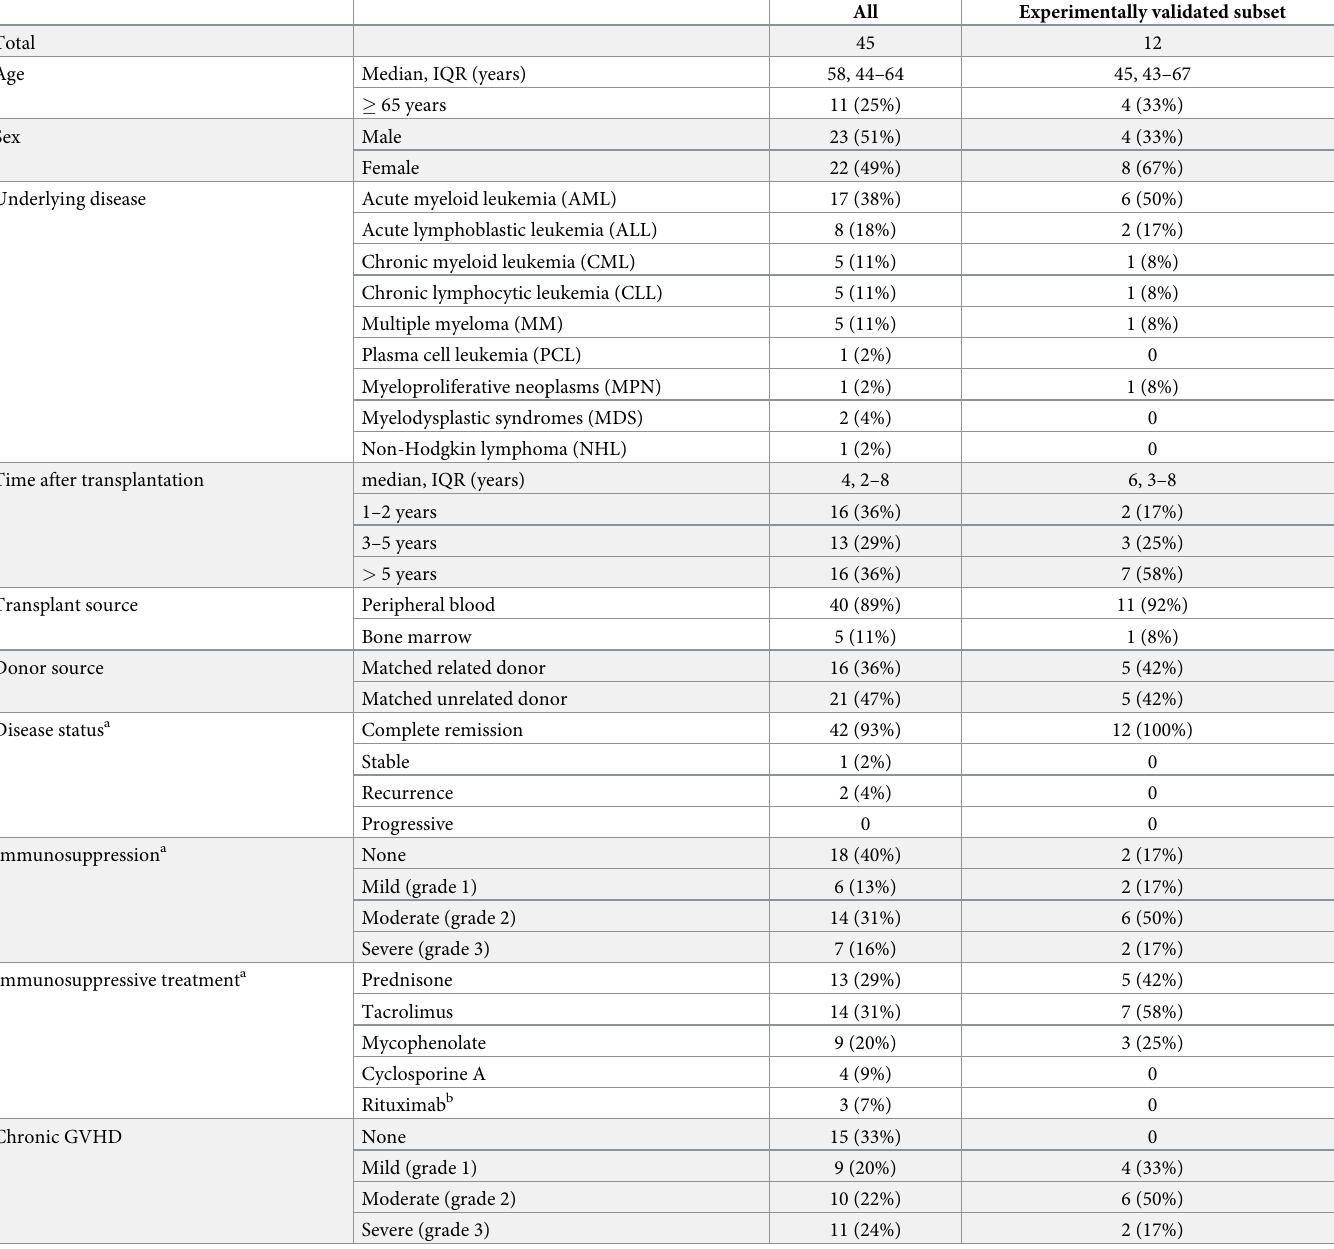
Table 2. Characteristics of allogeneic hematopoietic stem cell transplant patients (all patients and subset of patients with experimentally determined avidities for validation of inferred avidities). Abbreviations are: IQR, interquartile range; GVHD, graft-versus-host disease.